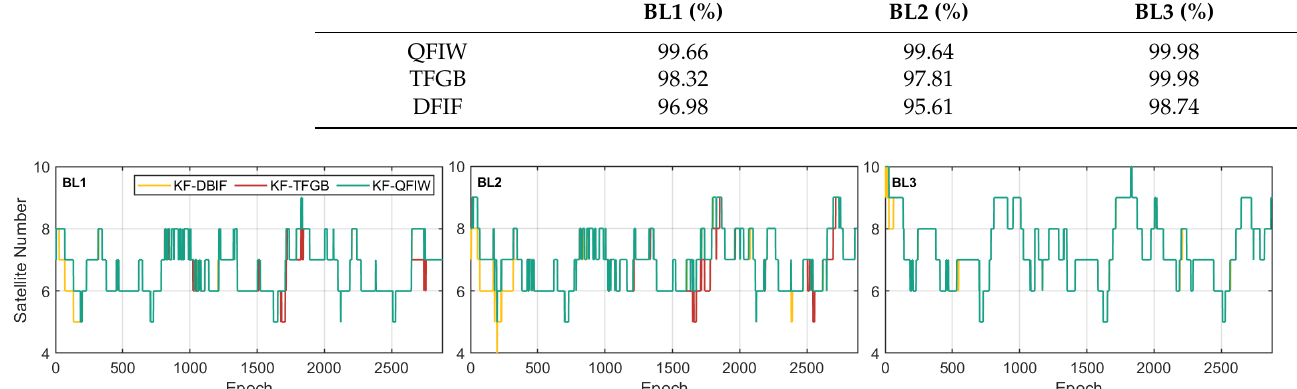
Figure 9. Number of satellites successfully fixed by QFIW, TFGB, and DFIF models.